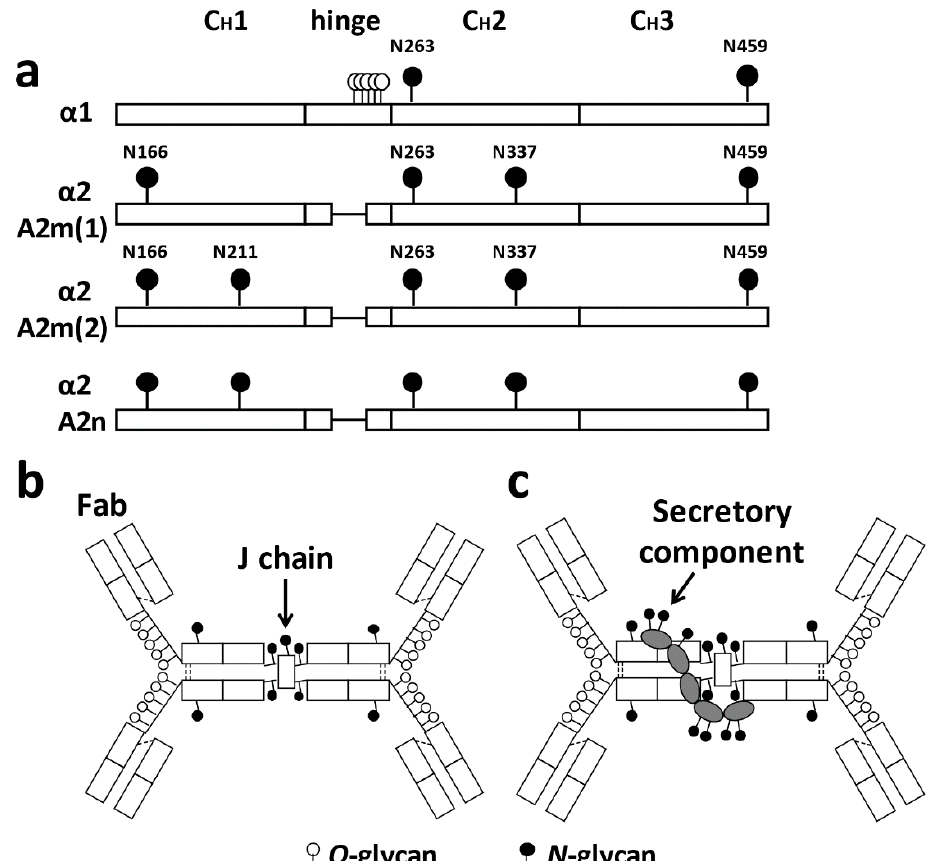
Figure 1. Molecular structure of IgA and its glycosylation sites. ( a ) Human IgA has two subclasses: IgA1 and IgA2. IgA1 harbors clustered O -glycans in its hinge region. IgA1 and IgA2 have several N -glycans in their constant region of heavy chains. IgA1 has two N -glycosylation sites at asparagine (Asn) 263 and Asn 459 . Three allotypes of IgA2 are known, designated A2m (1), A2m (2), and IgA2 (n). All allotypes have N -glycans at Asn 166 , Asn 263 , Asn 337 , and Asn 459 . A2m (2) and IgA2 (n) allotypes have a fifth N -glycan at Asn 211 [45]. ( b , c ) Schematic representation of dimeric IgA1 and secretory IgA1. Both the joining chain (J chain) and the secretory component have N -glycan(s). Fab, antigen-binding